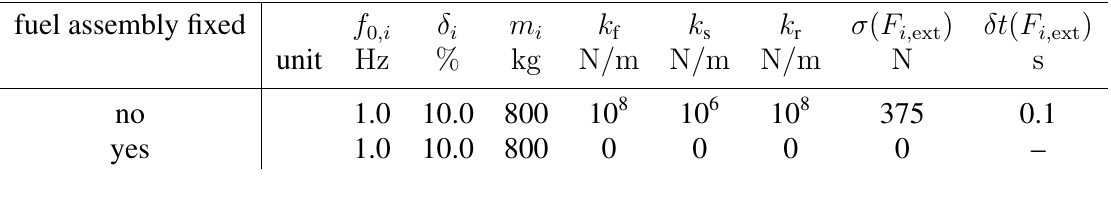
Table 1: Parameters used for the mechanical model ( i = 1 , 2 , . . . , 193 , ω 0 ,i = 2 π f 0 ,i